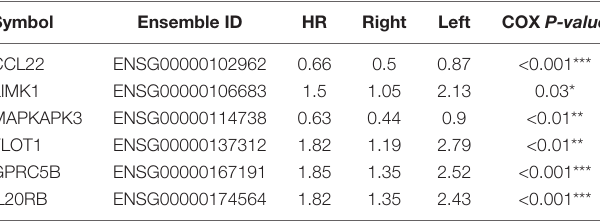
TABLE 2 | Survival analysis of the IRG in the prognostic